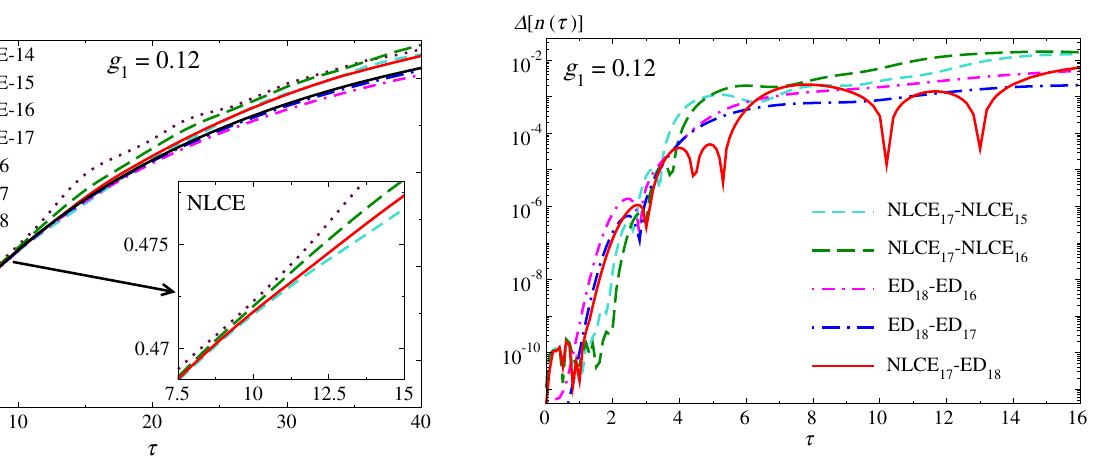
FIG. 9. Time evolution of the filling n ð τ Þ , for g 1 ¼ 0 . 12 , obtained in the last four orders l of the NLCE (NLCE- l in the legends), and in the three largest chains with L sites and periodic boundary conditions solved using full exact diagonalization (ED- L in the legends). The inset shows an enlargement of the NLCE results between τ ¼ 7 . 5 and 15.